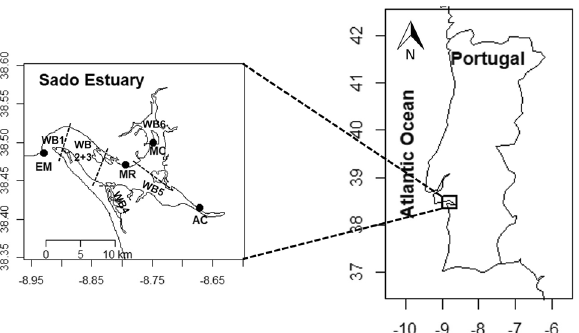
Figure 1. Map of the study area, Sado Estuary, with the location (black dots) and identification of each study site: AC—Alcácer channel, MC—Marateca channel, MR—middle region, and EM—estuary mouth. The maps were produced using the ‘maps’ package (3.4.0) from R (4.2.028). The water bodies (WB) currently used in the context of the WFD 72 are also